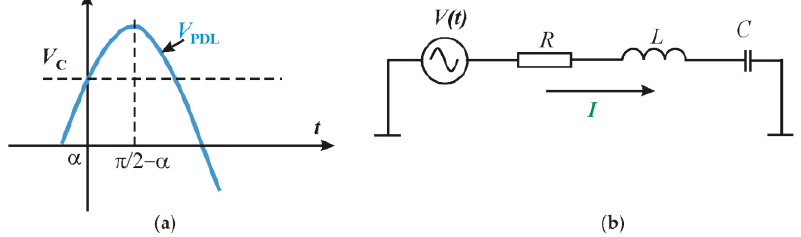
Figure 5. Calculation of the transient process: ( a ) voltages; ( b ) equivalent circuit.